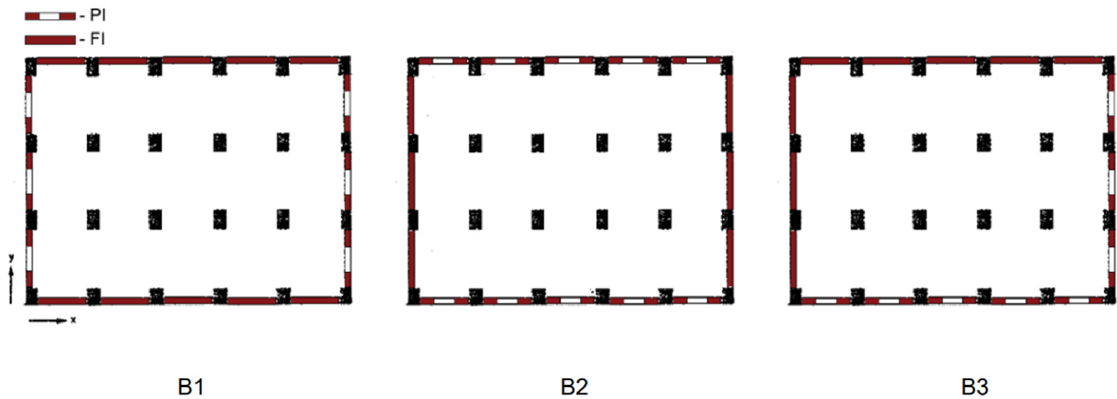
Figure 12. Models under study in Scenario B.